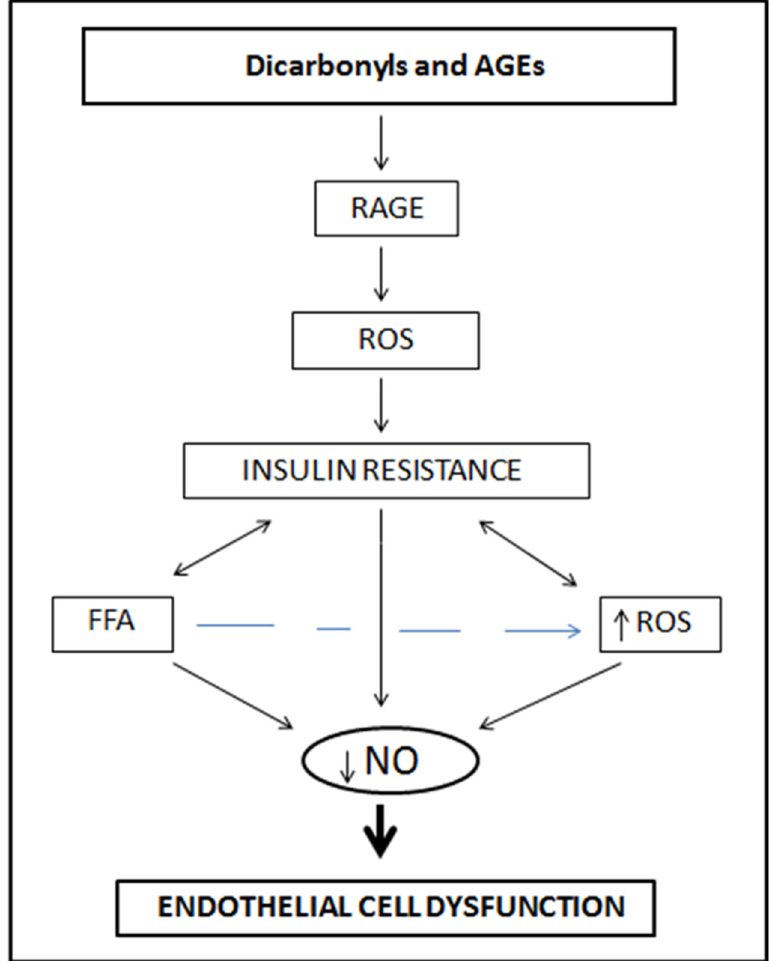
Figure 1. The relationship between dietary risk factor such as advanced glycation end products and endothelial cell dysfunction. endothelial cell